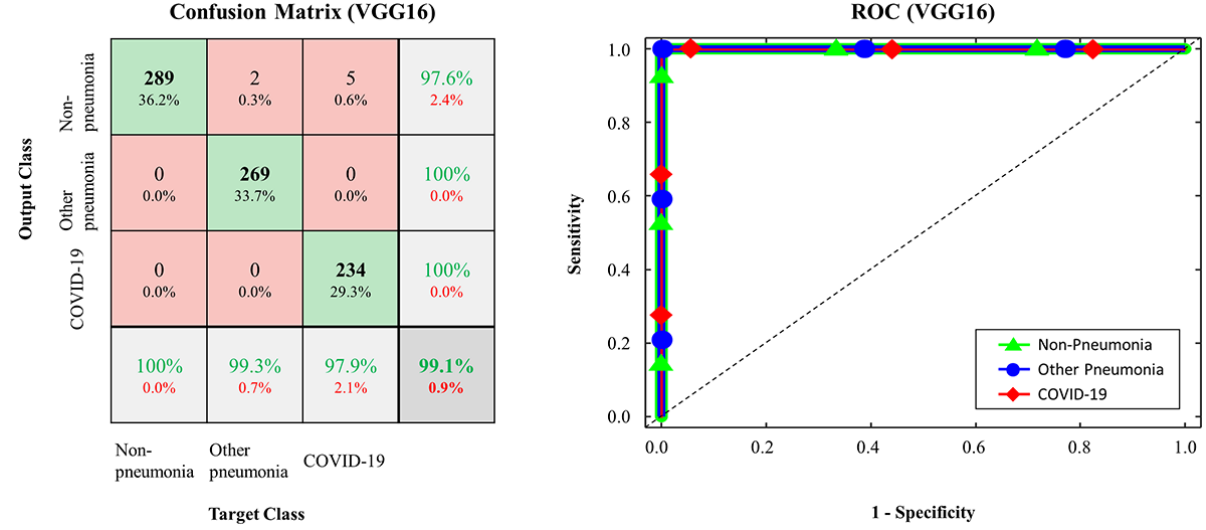
Figure 3. Confusion matrix and ROC curve in FCONet using VGG16; COVID-19: coronavirus disease; ROC: receiver operating characteristic.